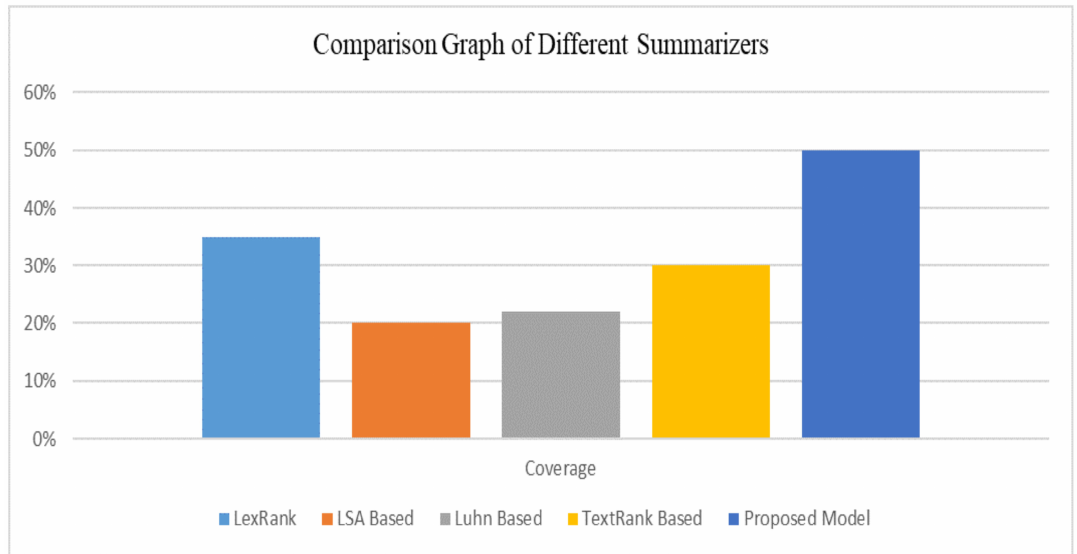
Figure 6. Shows the comparison graph of different summarizers. The proposed model is also compared with the LDA model, as shown in Figure 7.